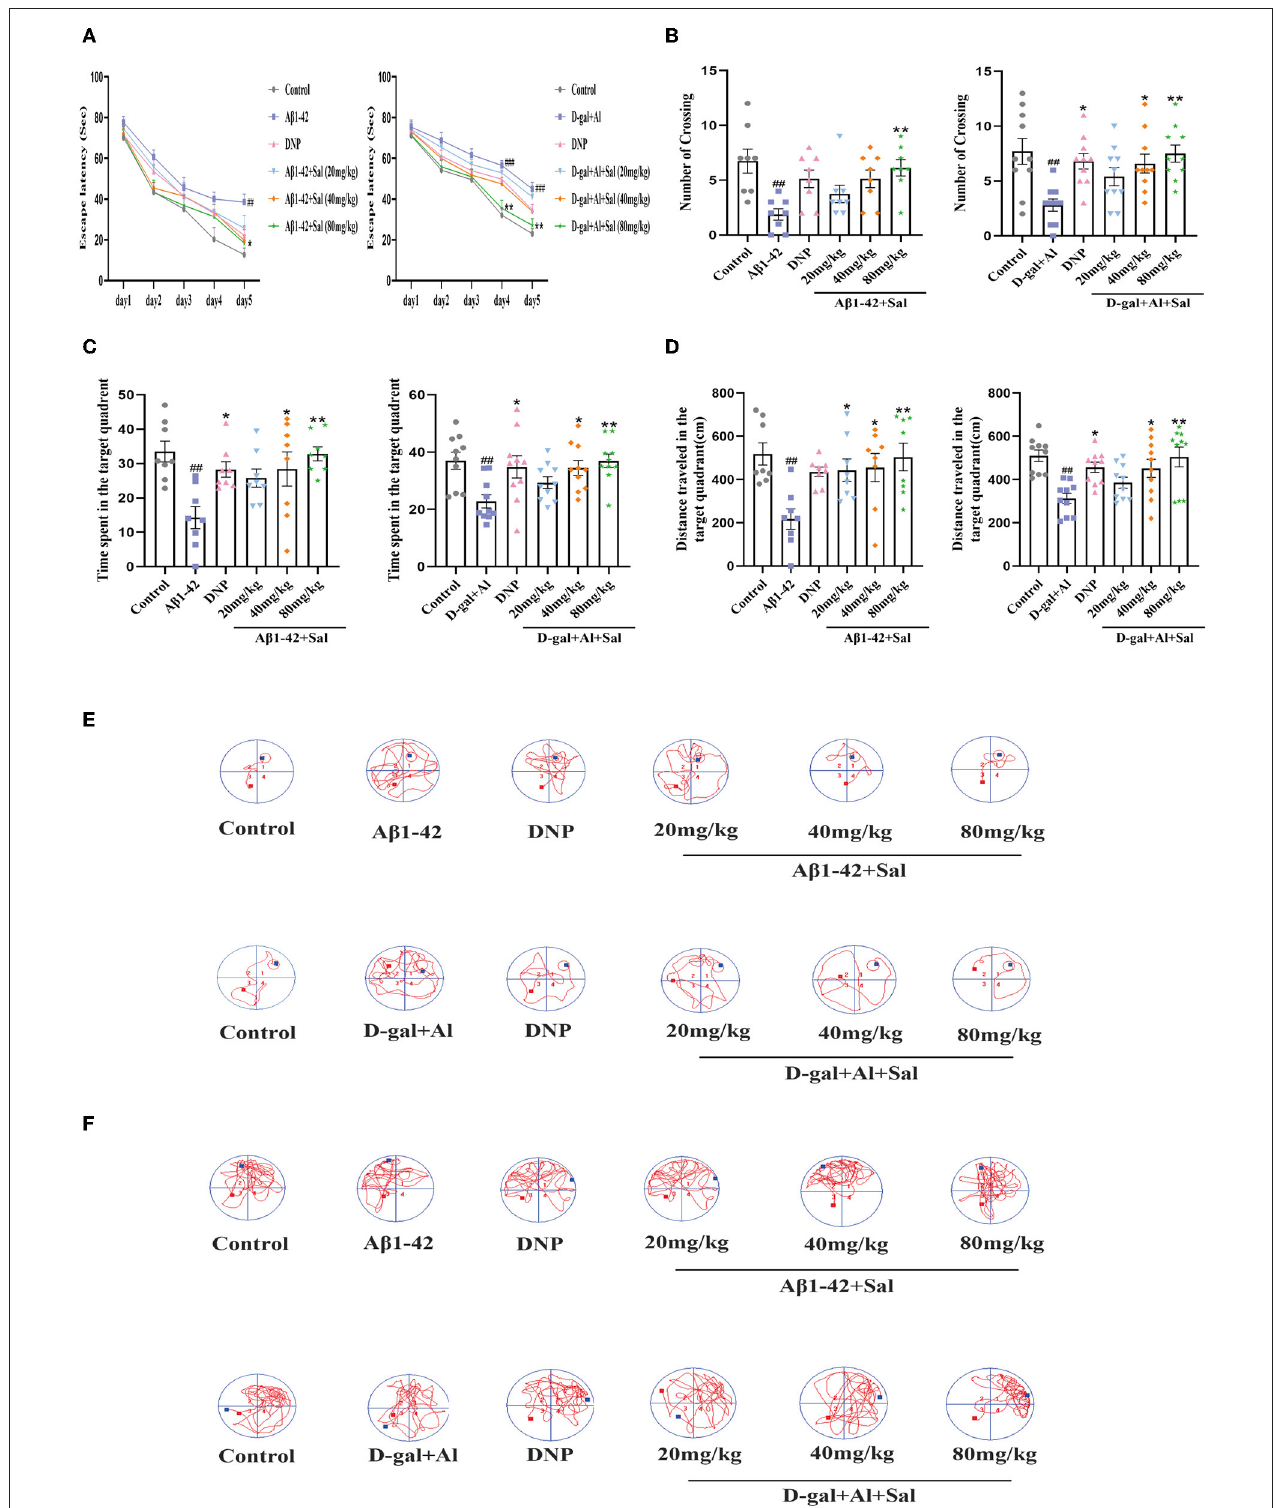
FIGURE 3 | Sal improves learning and memory function in A β 1-42 and D-gal/AlCl 3 -induced AD mice. The place navigation trial during the MWM. The Sal or DNP-treated AD mice showed a shorter escape latency over 5 days (A) . (B–F) The spatial probe trial during the MWM. The Sal or DNP-treated AD mice